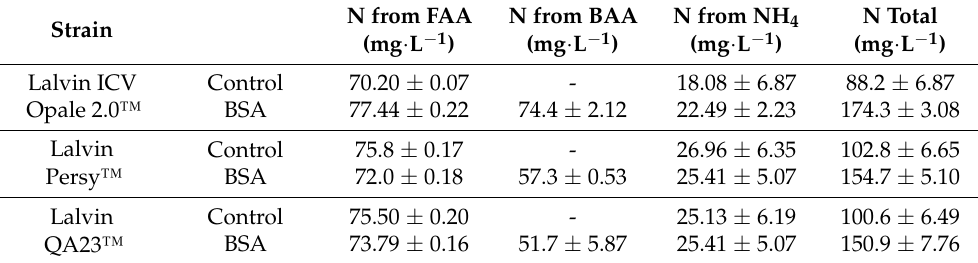
Table A3. The observed nitrogen consumption of free amino acids (FAA), bound amino acids (BAA) and ammonia during fermentation with Lalvin ICV Opale 2.0™, Lalvin Persy™ and Lalvin QA23™ of the modified synthetic must. ‘Control’ is without added peptides, ‘BSA’ is with added peptides. Standard deviations represent measurements in three technical replicates.